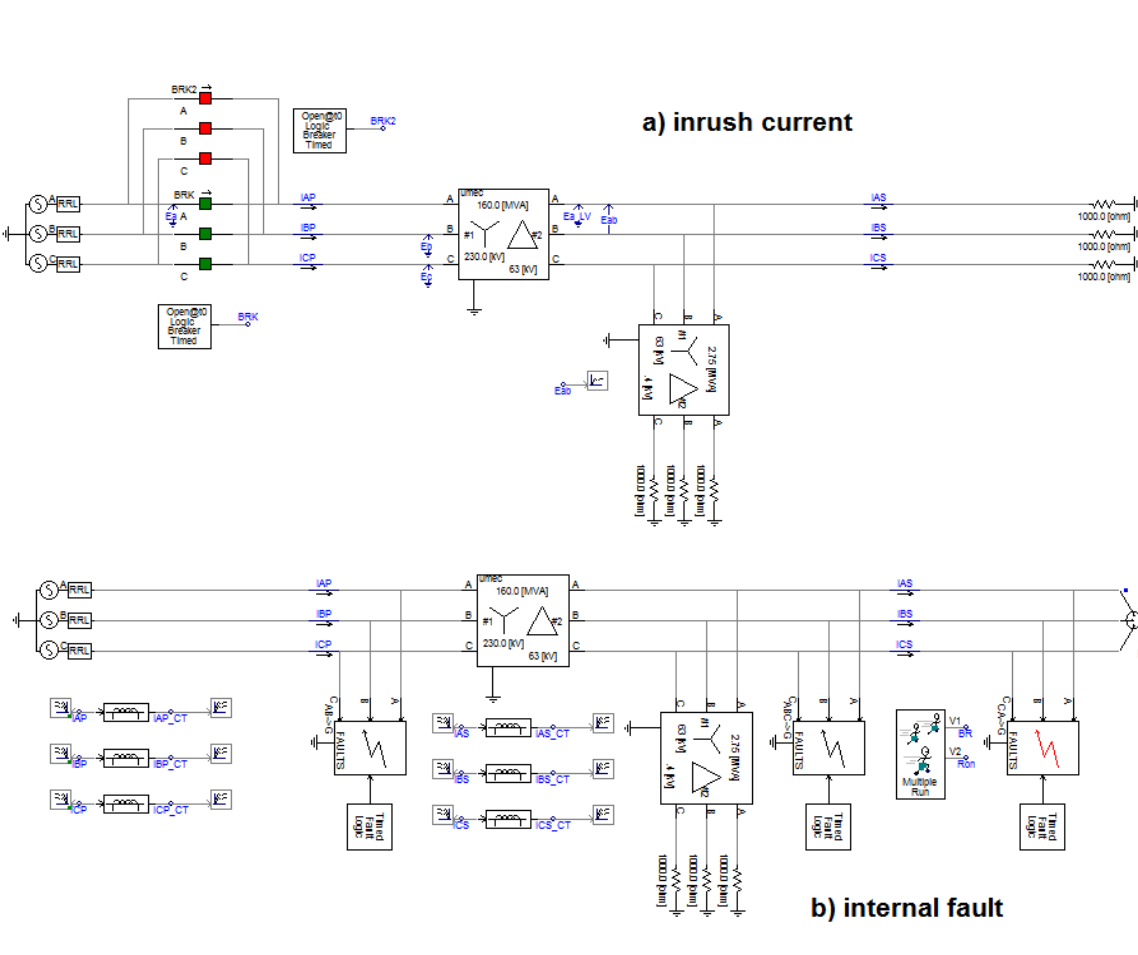
Figure 6. View of power system model, a) model of inrush current, b) model of internal fault